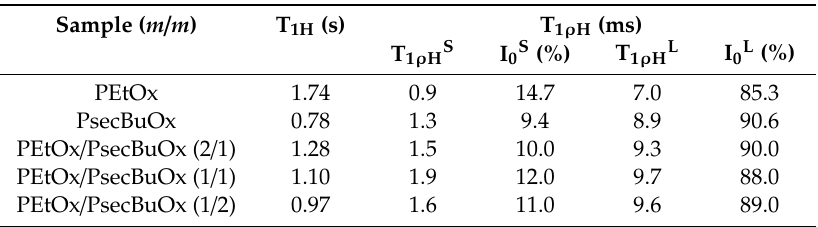
Table 2. Spin lattice relaxation times recorded with a lab frame (T 1 ) and a rotating frame (T 1 ρ ) of PEtOx, PsecBuOx and combinations of the two PAOx: 2 / 1, 1 / 1 and 1 / 2 ( m / m ). With the rotating frame, a short (S) and long (L) relaxation time was detected for all five samples. I 0 gives the percentages of both relaxation